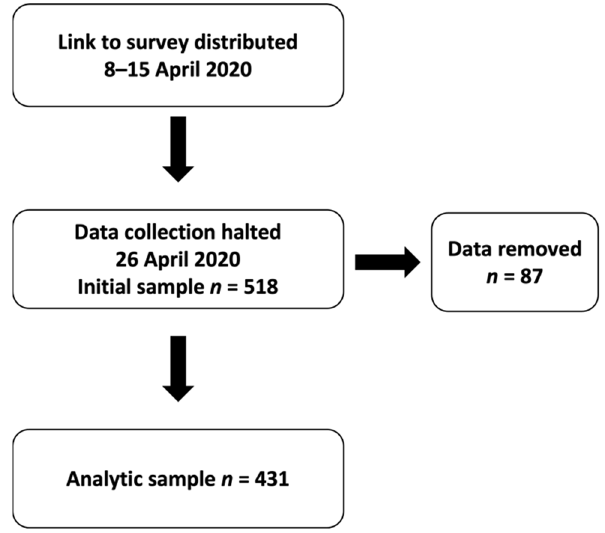
Figure 1. Flow diagram illustrating the timeline of participant recruitment and the removal of cases that had missing data.